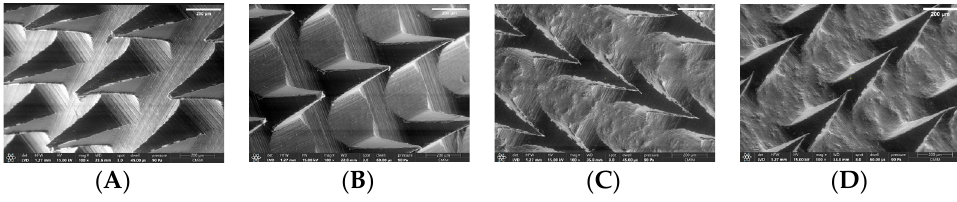
Figure 13. SEM Observation Results for the Selected Formulation ( A ) F4-MN NS, ( B ) F5-MN NS, ( C ) F8-MN CG, and ( D ) F11-MN CG (scale bar: 200 µm).